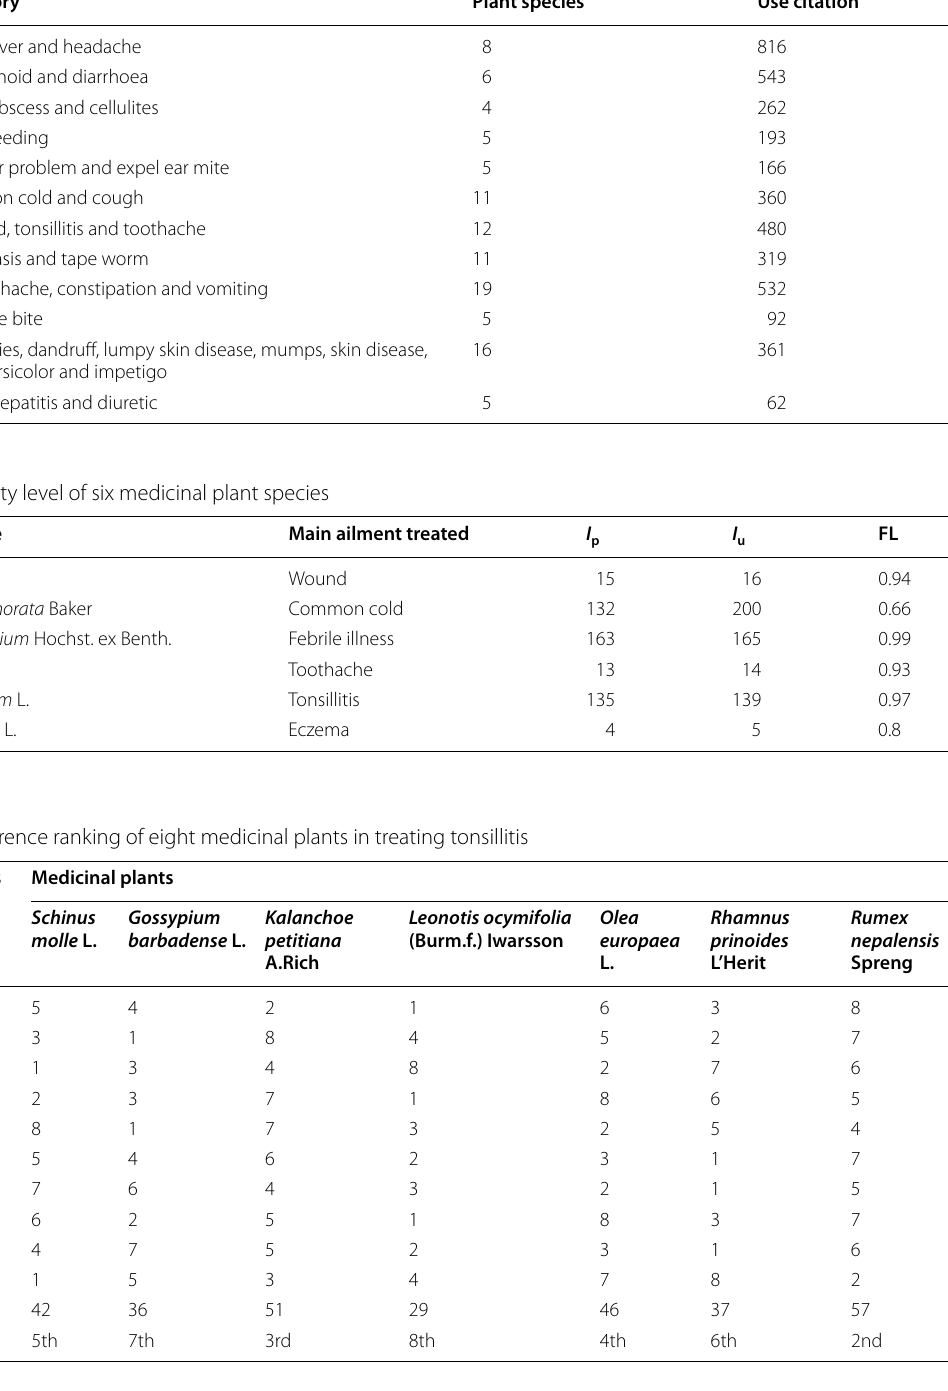
Table 3 Informant consensus factors for 12 categories of ailments Ailment category